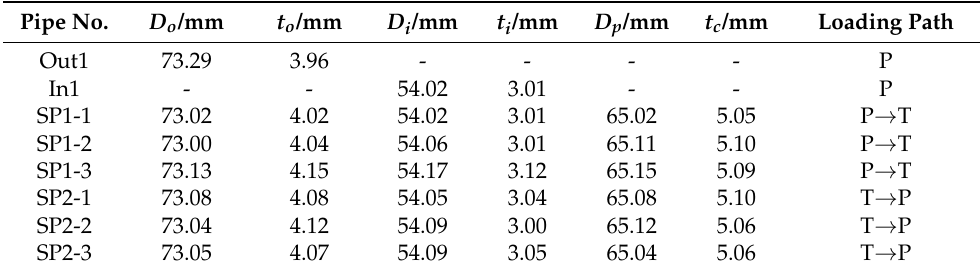
Table 1. Geometric features and production method of